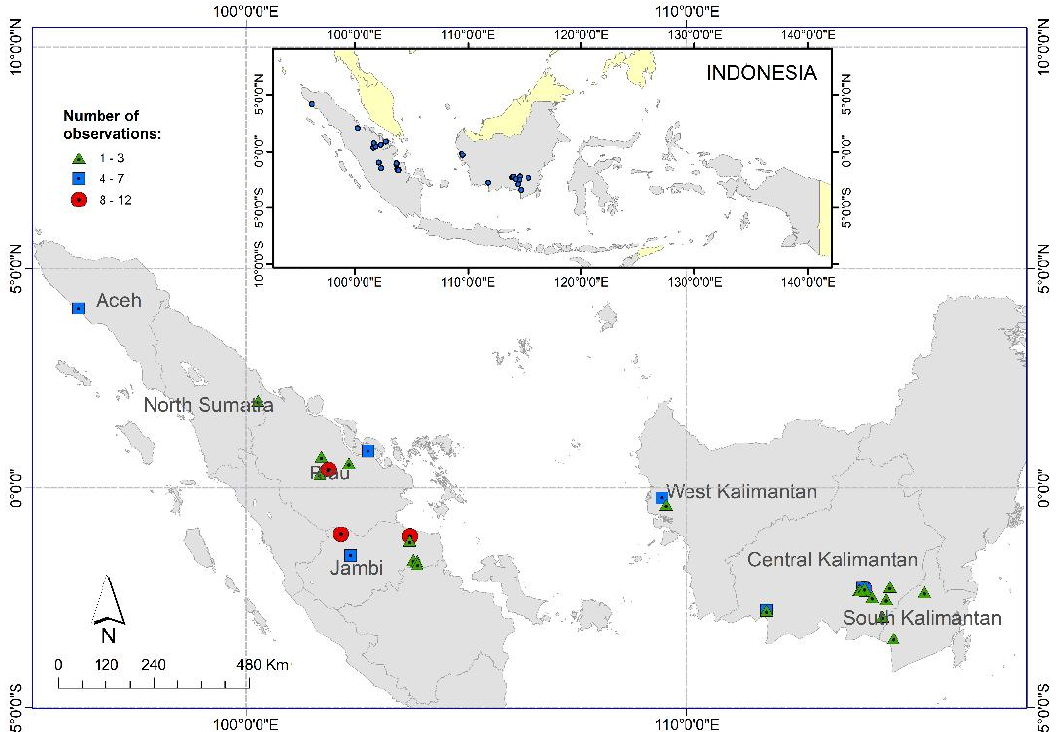
Figure 1. Geographical extent of the primary study areas used for the meta-analysis. Green diamonds, blue squares, and red circles denote the numbers of observations for 1–3 data observations, 4–7 data observations, and 8–12 data observations, respectively.